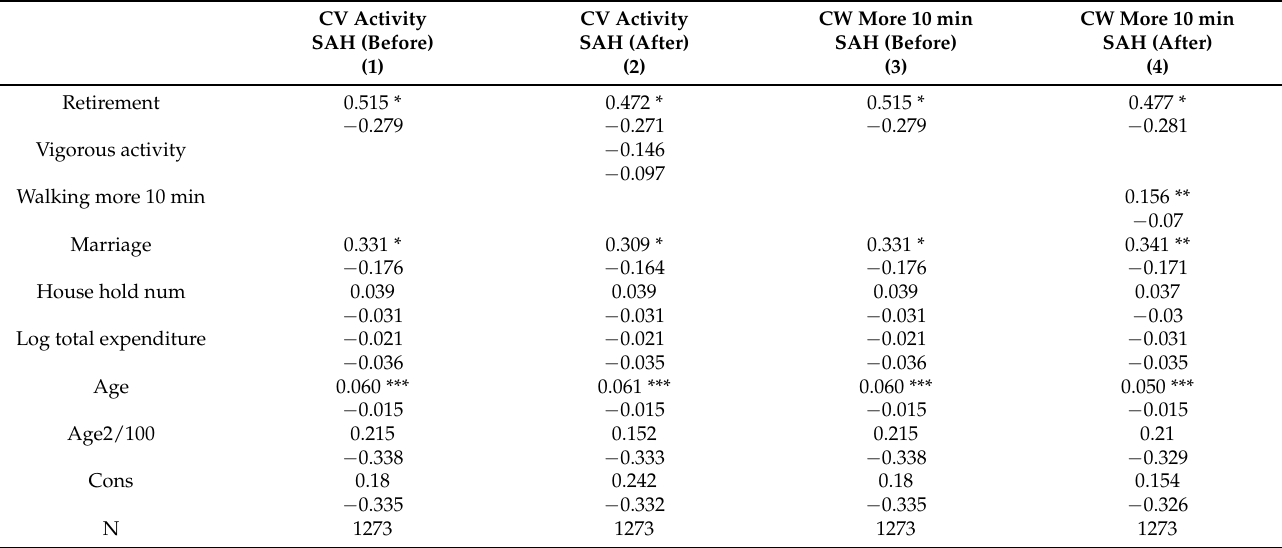
Table A8. Effect of retirement on SAH after controlling channel